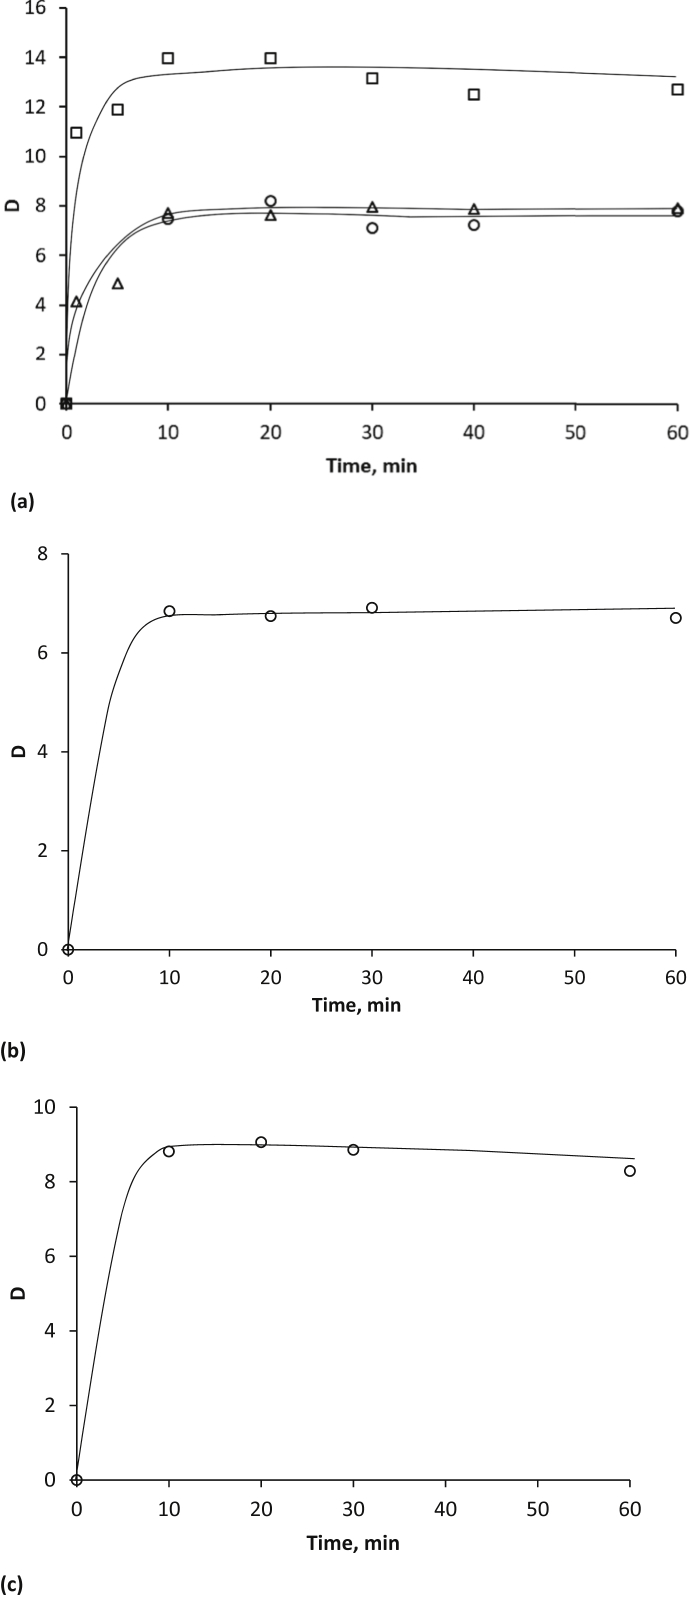
Dependence of distribution coefficients for aromatic acids on the time of phase contact in a) the PEG-1500 – Na2SO4 – H2O ATPS at 25°С: ○ – benzoic acid, □ – salicylic acid, and △ – sulfosalicylic acid, in b) the PEG-1500 – (NH4)2SO4 – H2O ATPS at 25°С, in c) the PEG-1500 – (NH4)2HPO4 – H2O ATPS at 25°С.